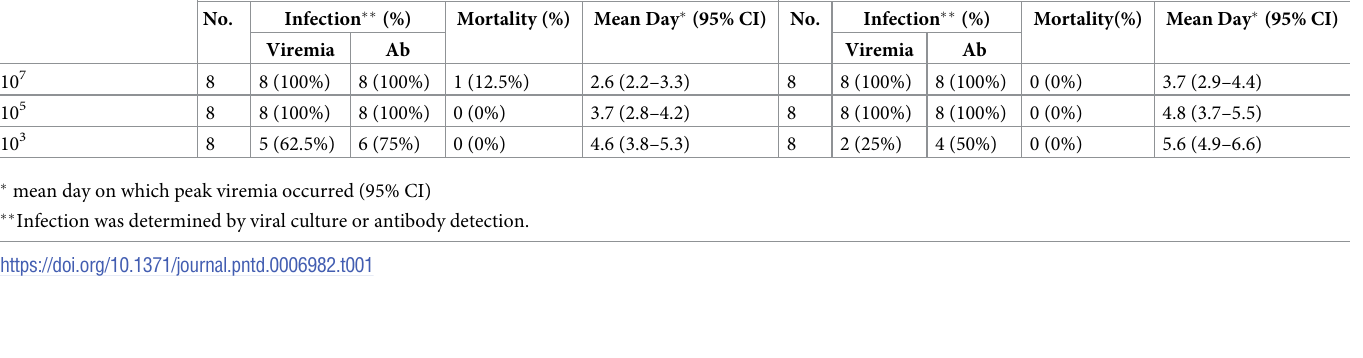
Table 1. Susceptibility of spotted doves to SFTSV infection is dependent on challenge dose. Challenge dose (PFU)